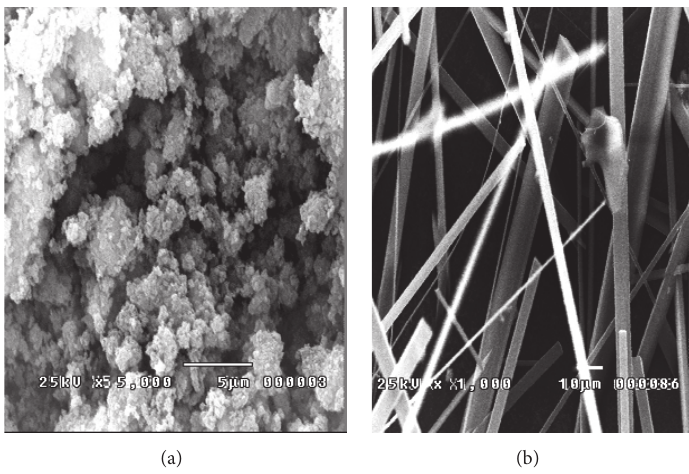
Figure 3: SEM images of (a) bulk FePc (powder) and (b) nano-FePc (crystalline).